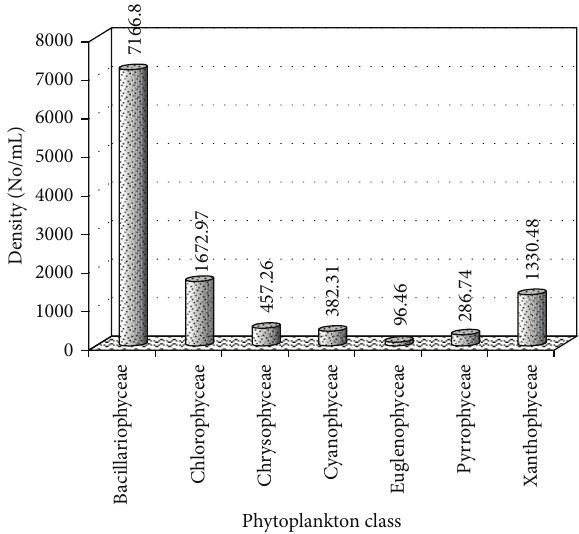
Figure 2: Overall mean value of phytoplankton density in Okpoka